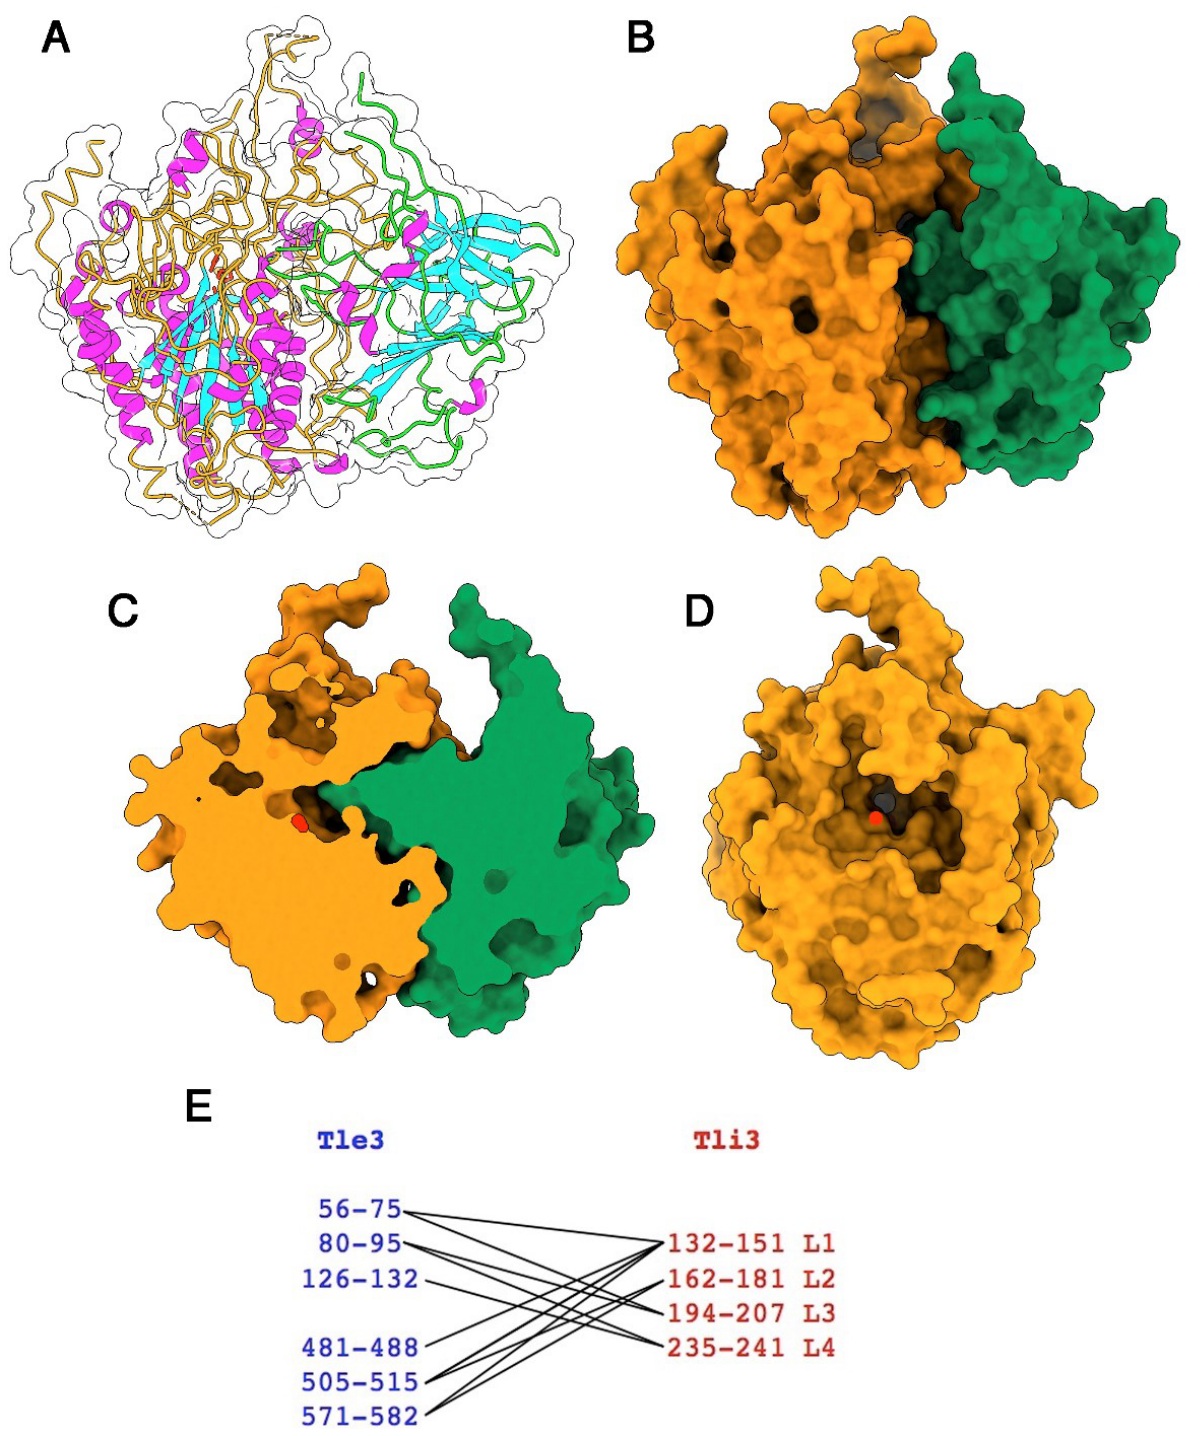
Figure 3. Structure of the Tle3 AIEC /Tli3 AIEC complex. ( A ) Ribbon view and protein surface (white transparent) of Tle3 AIEC backbone colored orange and Tli3 AIEC backbone colored green. The catalytic triad is colored red, helices and strands are colored purple and blue, respectively. ( B ) Molecular surface of the Tle3 AIEC /Tli3 AIEC complex (same colors as in ( A ). ( C ) Molecular surface of the Tle3 AIEC /Tli3 AIEC complex cut at the catalytic triad (red) level. Same orientation as in ( B ). ( D ) Molec- ular surface of Tle3 AIEC rotated 90 ◦ as compared to ( B ) evidencing the catalytic crevice with the catalytic triad position indicated at its bottom (red). ( E ) Schematic representation of the Tle3 AIEC (blue) and Tli3 AIEC (red) interacting in the complex.